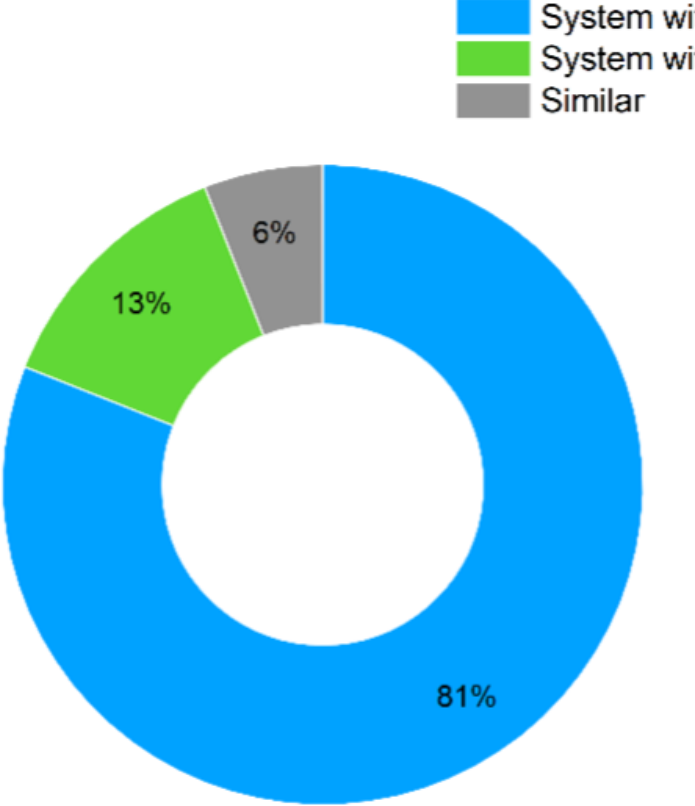
Figure 45. User preference for the system with